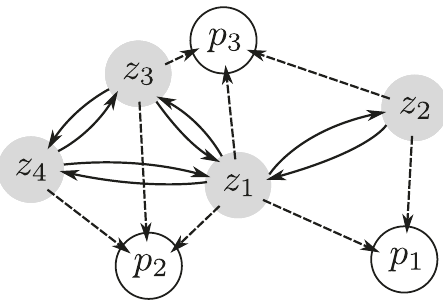
Fig. 9 Neural message-passing with probe nodes. Neural network computed messages are exchanged between atom vertices in several steps while the probe nodes only receive messages. The contents of the messages depend on the hidden state of the vertices and the states are updated after each message-passing